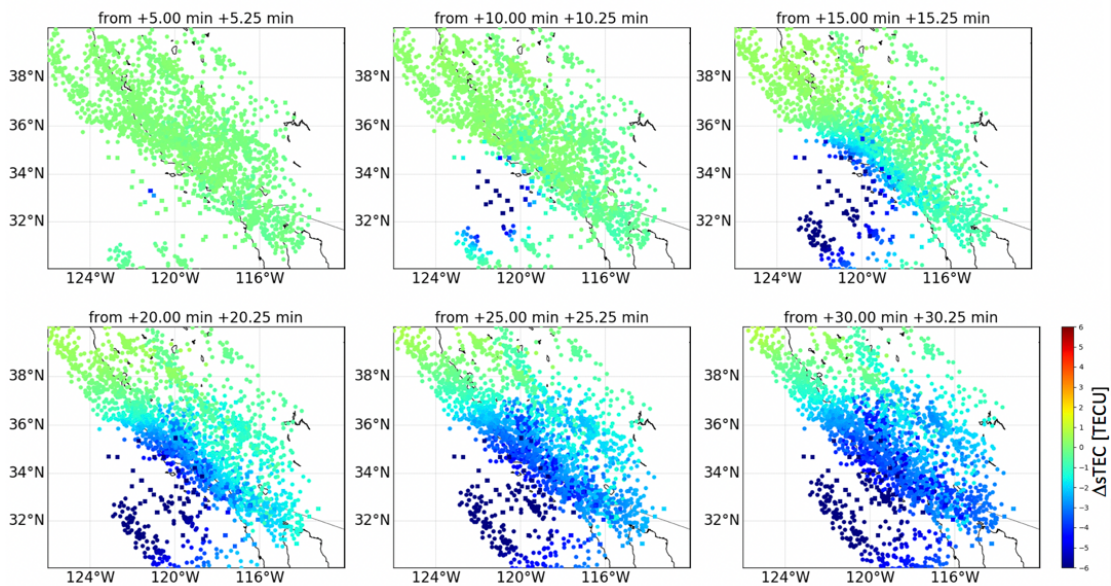
Figure 7. Space-time ∆ sTEC variations for 30 min after the launch (one frame every 5 min) at the SIPs (same positions of the corresponding IPPs on the map) for the 2 GEO satellites (square symbols) and six GPS satellites (denoted by circles) seen from the 62 GNSS permanent stations. The ionospheric hole is detected from both GEO satellites 5 min after the rocket launch. The coordinates are expressed in geodetic latitude (in degrees North) and longitude (in degrees